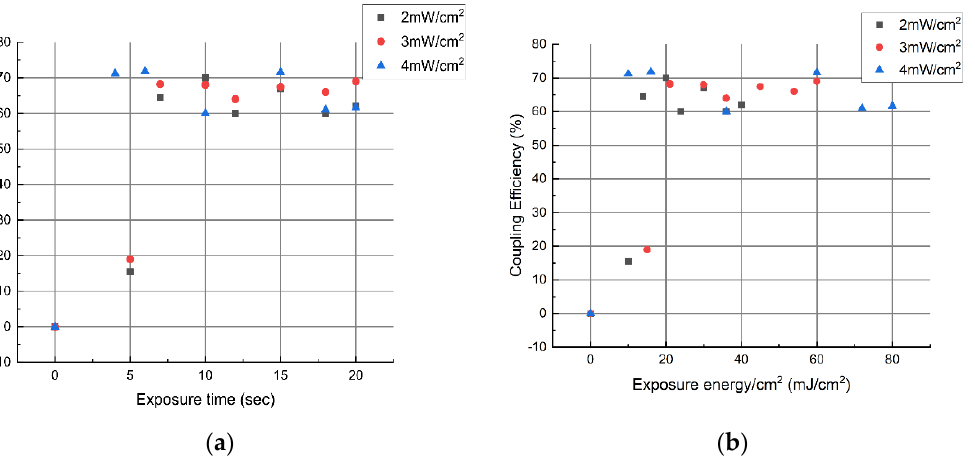
Figure 9. ( a ) Coupler diffraction efficiency vs. exposure time. ( b ) Coupler diffraction efficiency vs. exposure energy.